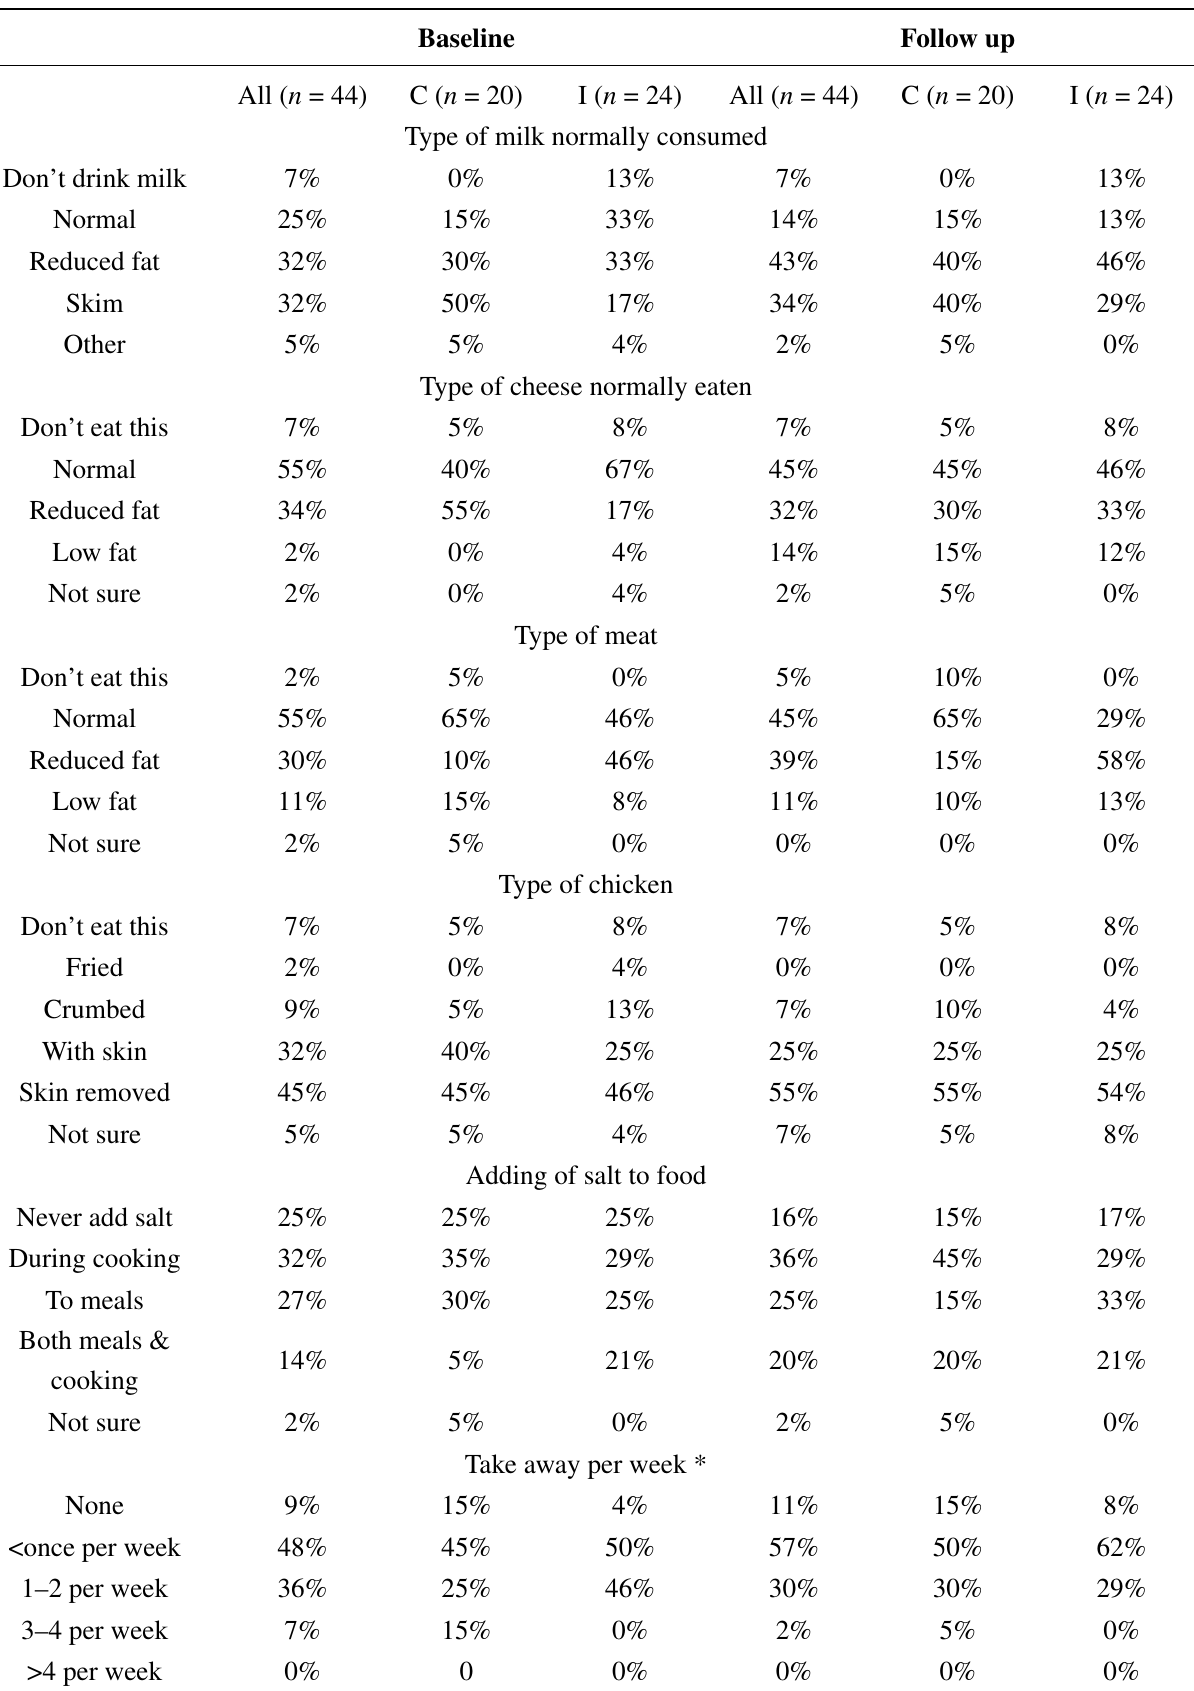
Table 3. Reported eating habits of foods related to cardiovascular disease (CVD)